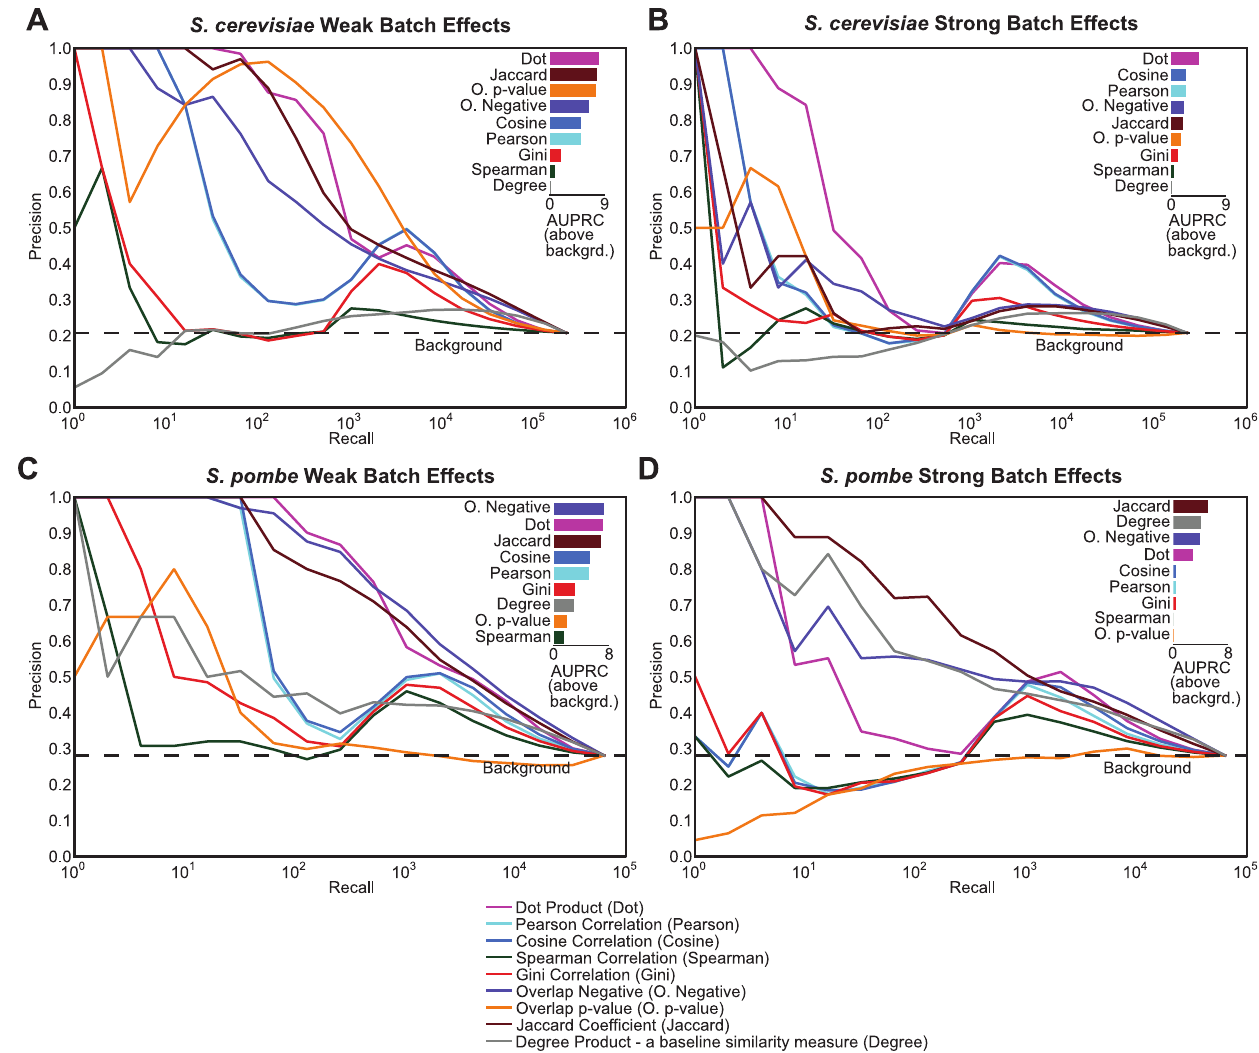
Figure 6. Role of simulated batch effects in genetic interaction data on similarity measure performance. (A) shows the performance of similarity measures on the query side of the S. cerevisiae genetic interaction network when simulated intermediate batch effects were added to the data. The batch effects were added by creating random batches of size 5 and for each batch, Gaussian noise ( m =0 and s =0.02) was added. Furthermore, Gaussian noise ( m =0 and s =0.02) was added to entire dataset. (B) A stronger batch effect signature and noise was added ( m =0, s =0.04 for both batch effect and noise) (C), (D) are similar plots for the query side of the S.pombe genetic interaction data ( m =0, s =1 for (C), and m =0, s =2 for (D)). The bar plot on the upper right corner in each section shows the area under the precision-recall curve (AUPRC) above the background for each similarity measure. The area was calculated by summation of the areas of trapezoids at in increments of 2 n (log 2 units). The bars are sorted by their respective areas above